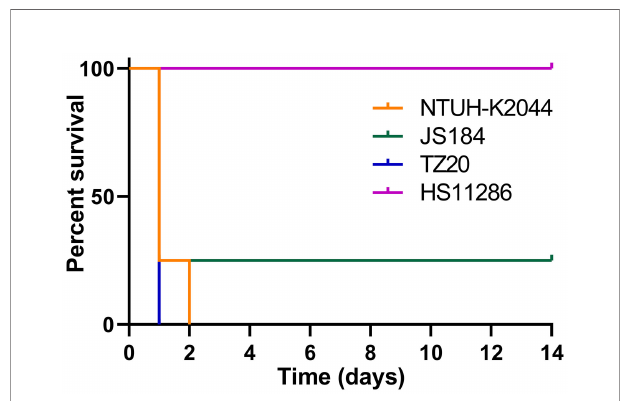
FIGURE 8 | Survival curves of mice inoculated with two bla KPC (+)-HvKP strains. bla KPC (+)-HvKP, beta-lactamase K. pneumoniae carbapenemase gene-positive hypervirulent Klebsiella pneumoniae .